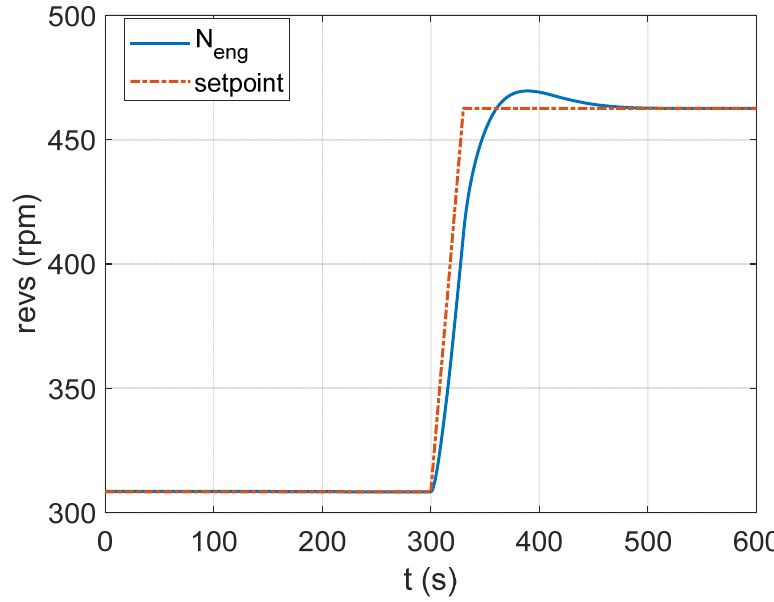
Figure 1. Revolution response to rpm ramp.